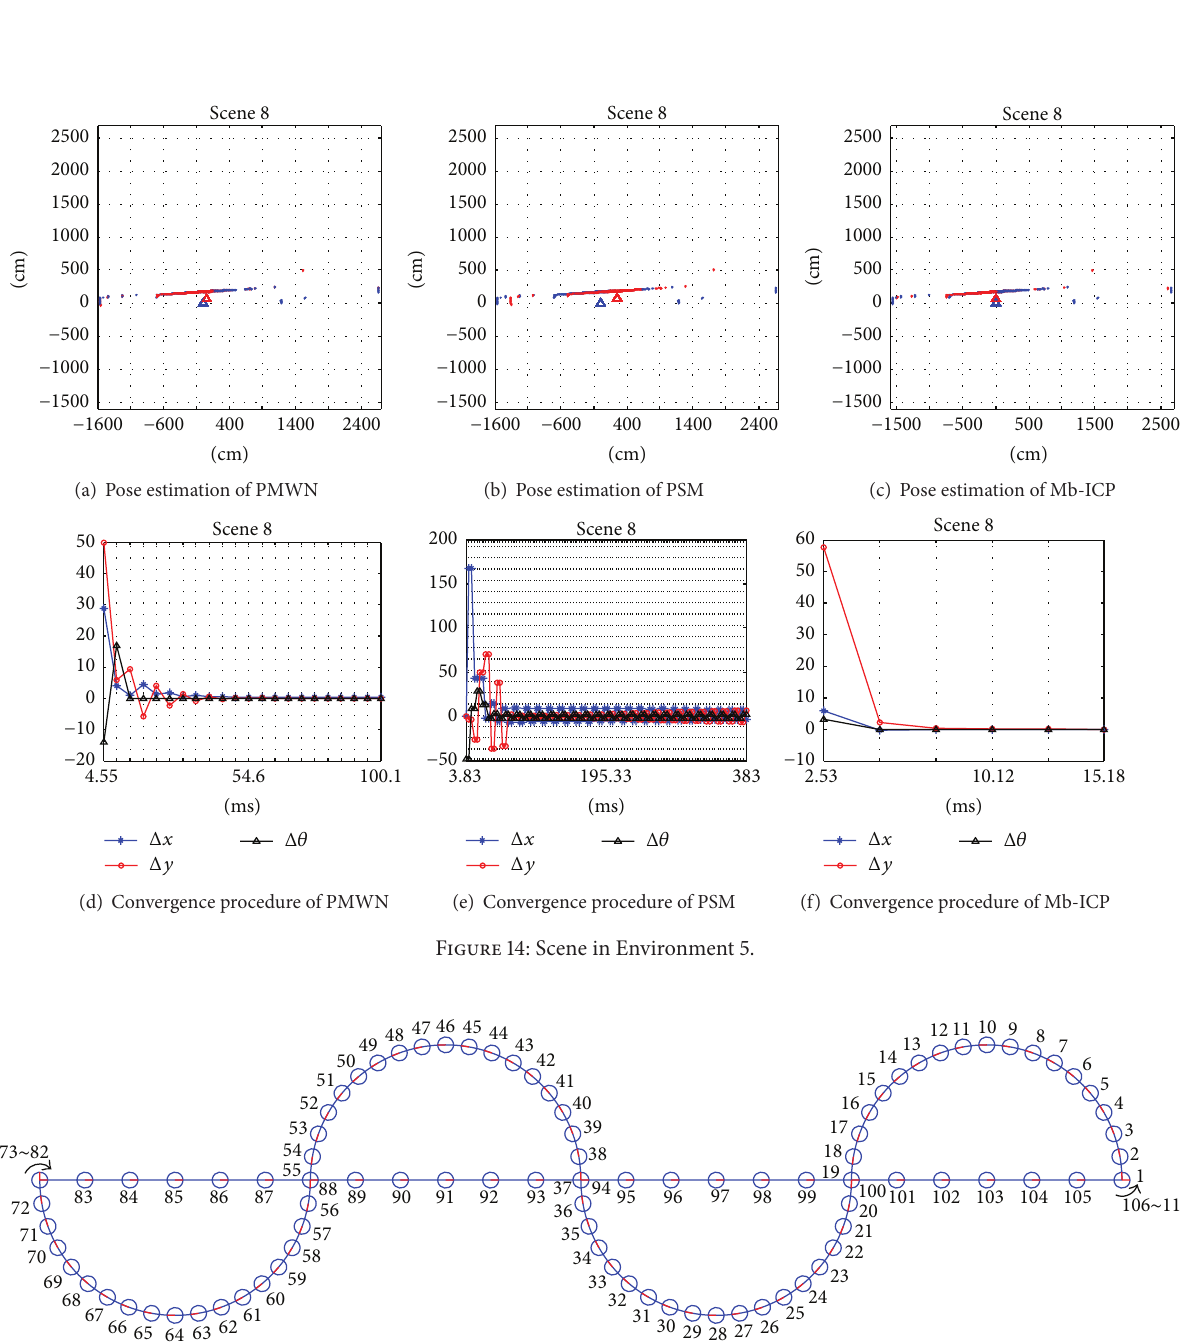
Figure 15: Footprint on the flat